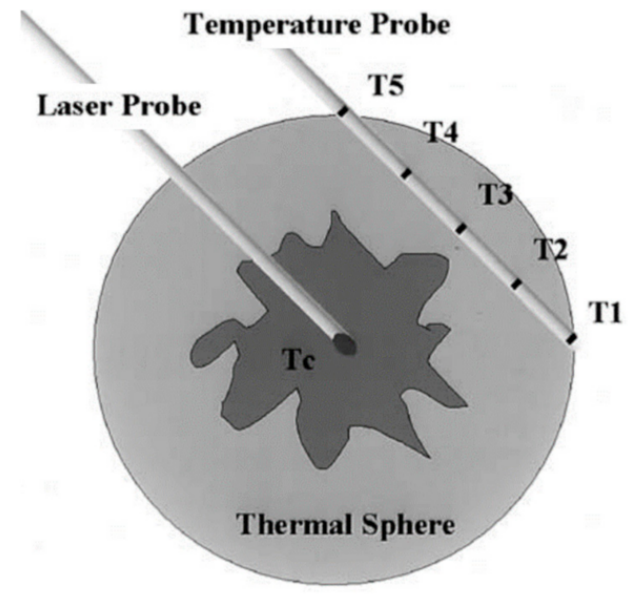
Figure 2. Schematic of laser and a temperature probes within and adjacent to the breast tumor. T1–T5 are peripheral thermal sensors. Adapted with permission from